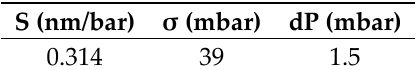
Figure 2. Calibration diagram of the optical pressure sensor. Table 1. Metrological characteristics of the pressure sensor: sensitivity, S, accuracy, σ and resolution